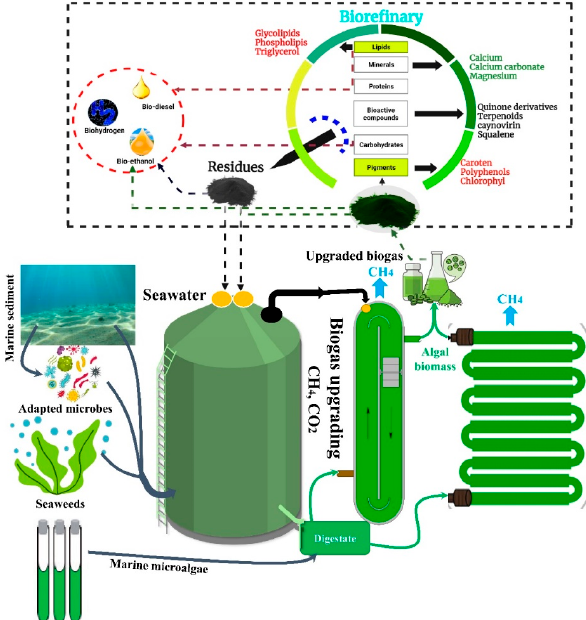
Figure 6. Overview of the suggested approach for integrated marine biorefinery to achieve a ze- ro-waste marine biogas system, where seawater and seaweed could be potentially applied for bi- ogas production integrated with marine microalgae cultivation on the digestate and